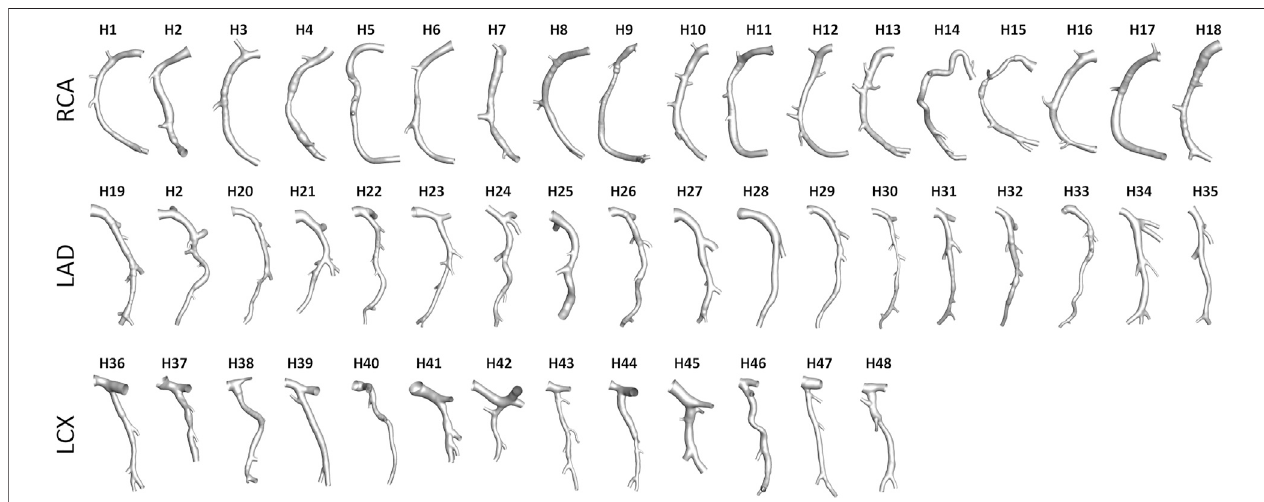
FIGURE 2 | Geometry of the 49 human coronary artery models. Labels from H1 to H48 identify the single patient. Right (RCA), left anterior descending (LAD), and left circum fl ex (LCX) coronary artery geometries are grouped.